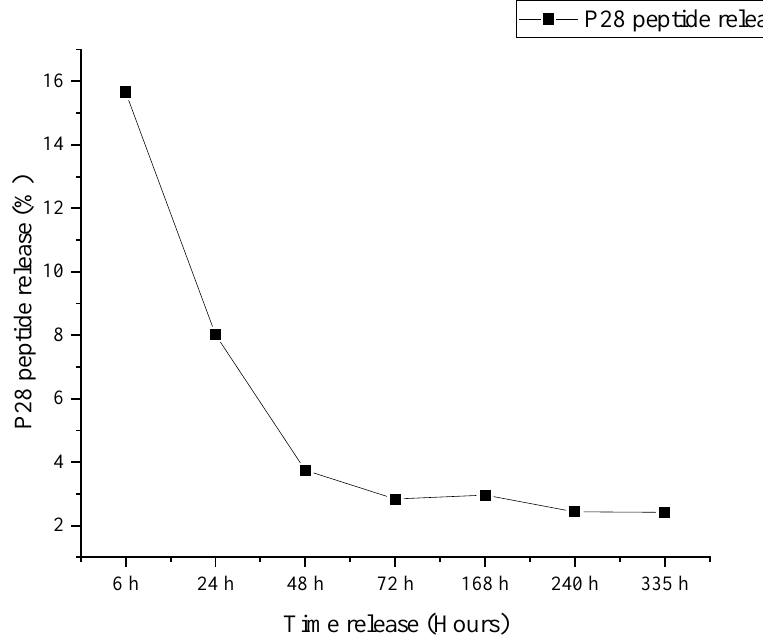
Figure 2. P28 release profile showing an initial burst release in the first 48 h, followed by a sustained release until 335 h (14 days).